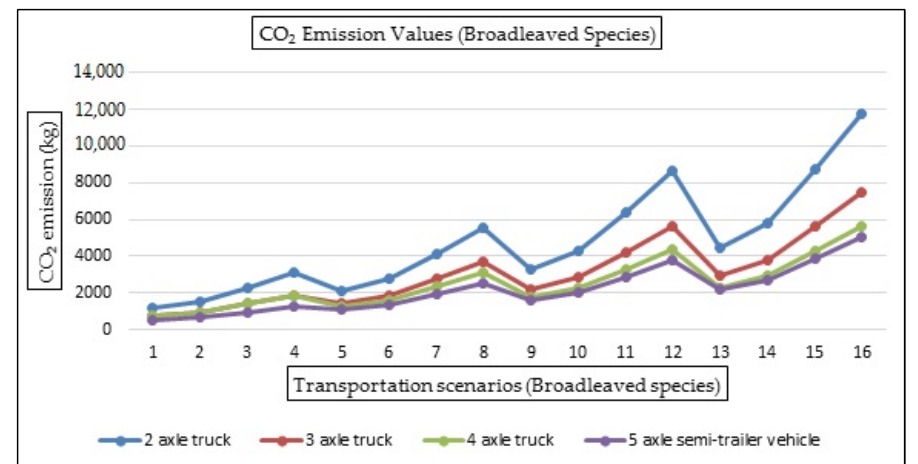
Figure 7. CO 2 emission values for coniferous species in terms of transportation scenarios. Table 18. Fuel consumption and CO 2 emission values in terms of broadleaved species according to transportation scenarios.